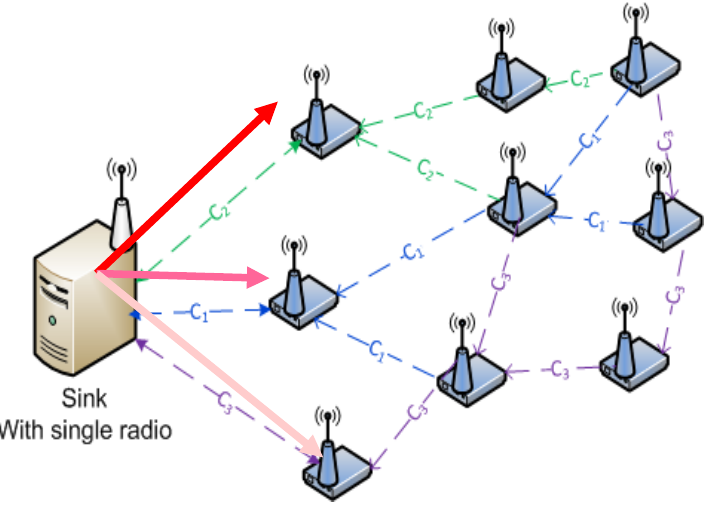
Figure 15. Sink node with single radio doing channel